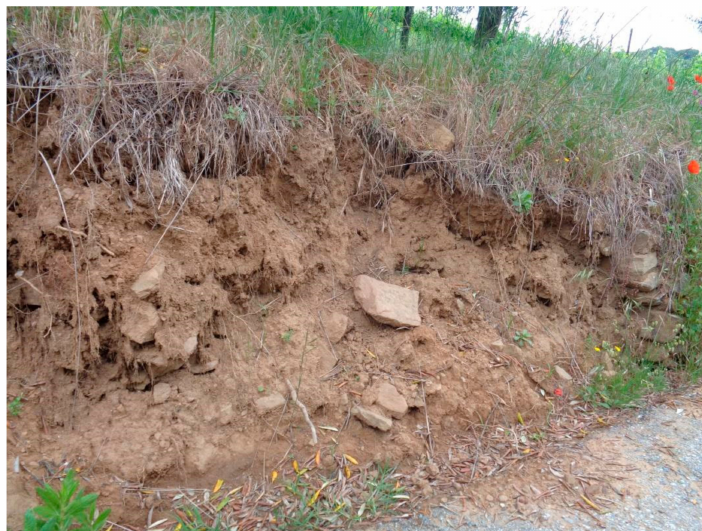
Figure A6. Damage class 6—Dry-stone wall